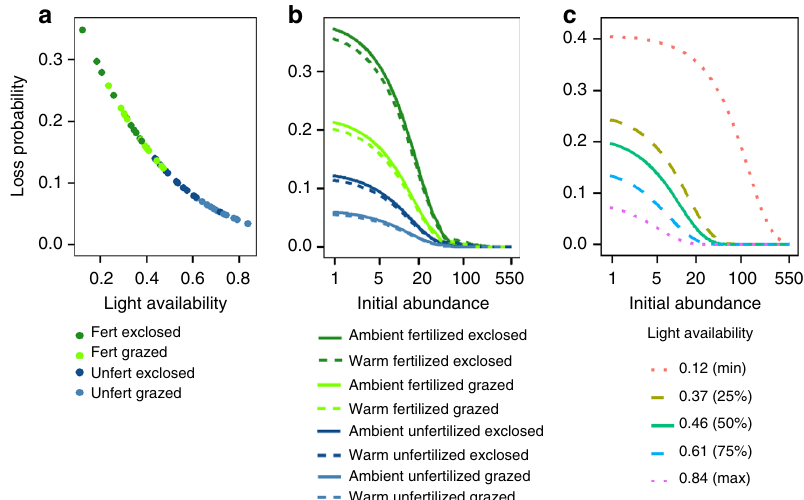
Fig. 3 Probability of species losses as a function of their initial abundance and light availability. Modeled probability of species losses as functions of a light availability (measured as the proportion of ambient PAR), b rarity, or species initial abundance (measured as hits per 100 pins per 25×50 cm 2 quadrat) under warming, grazing and fertilization treatments, and c interaction between light availability and initial abundance. In a and b , fertilized plots are in green , unfertilized in blue . Herbivore exclosures are indicated with dark color , grazed plots in light color . In b , dashed line indicates prediction for warmed plots, solid line for unwarmed plots (with ambient temperature). In c , green solid line shows loss probability when light availability is 50% of ambient PAR, while dashed lines indicate 25 and 75% quantiles and dotted lines minimum and maximum measured proportion of PAR. Modeling results can be found in